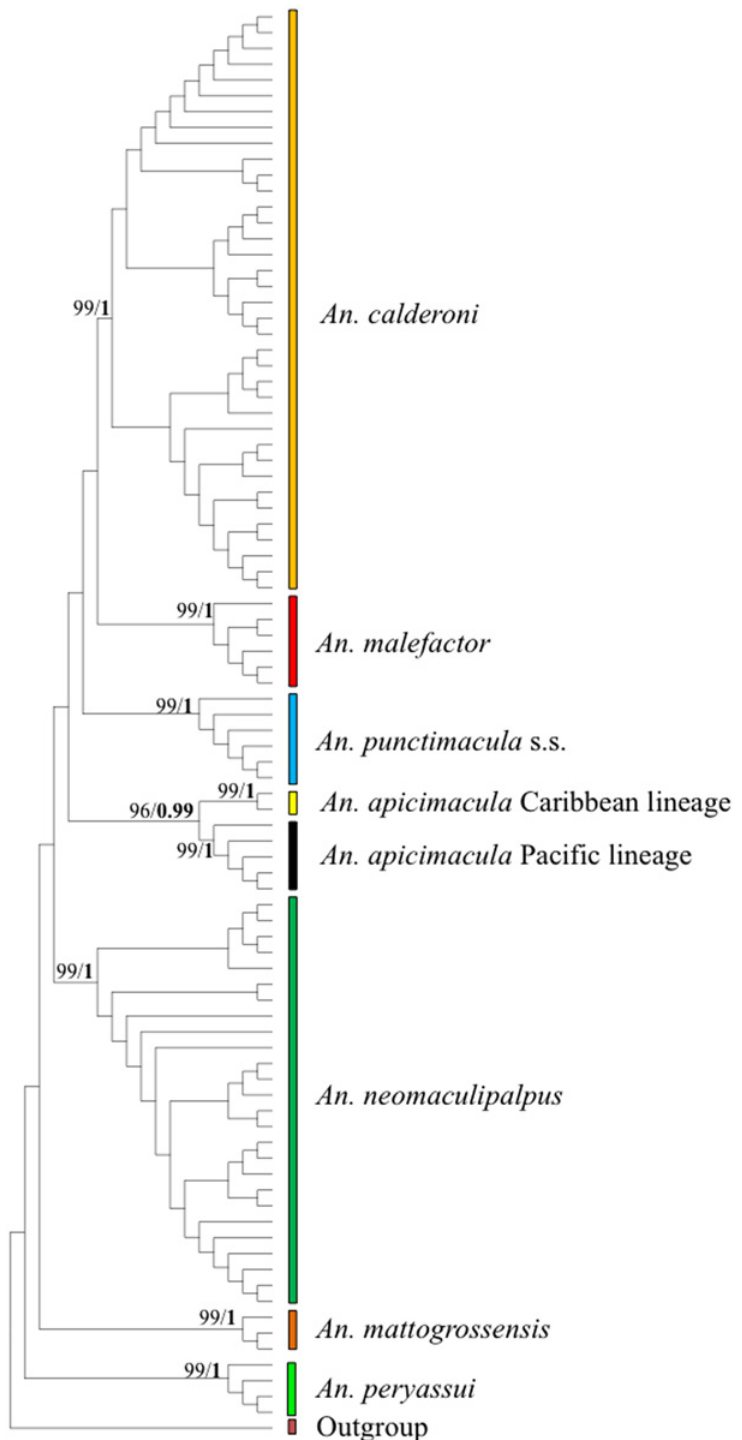
Fig 2. NJ topology based on barcode ( COI ) sequences for members of the Arribalzagia Series. First number in each node indicate NJ bootstrap values (in percentages), numbers in bold indicate Bayesian posterior probability for each MOTU. Anopheles pseudopunctipennis was included as the outgroup.